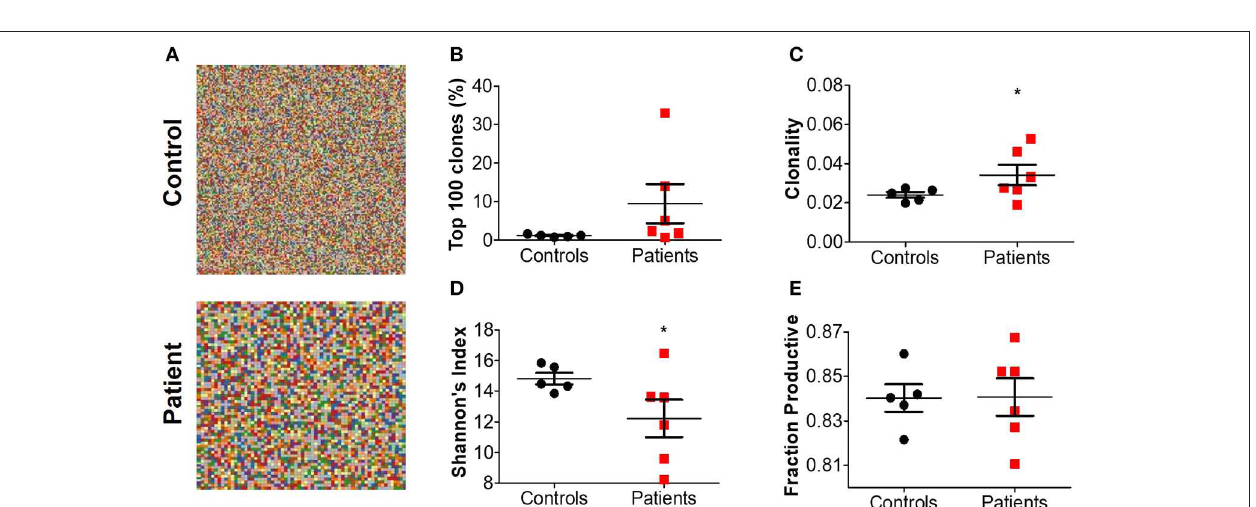
insulin-dependent diabetes mellitus a slight, yet significant decrease in CDR3 β length may be associated an increased potential for self-recognition (39). The decreased CDR3 β length